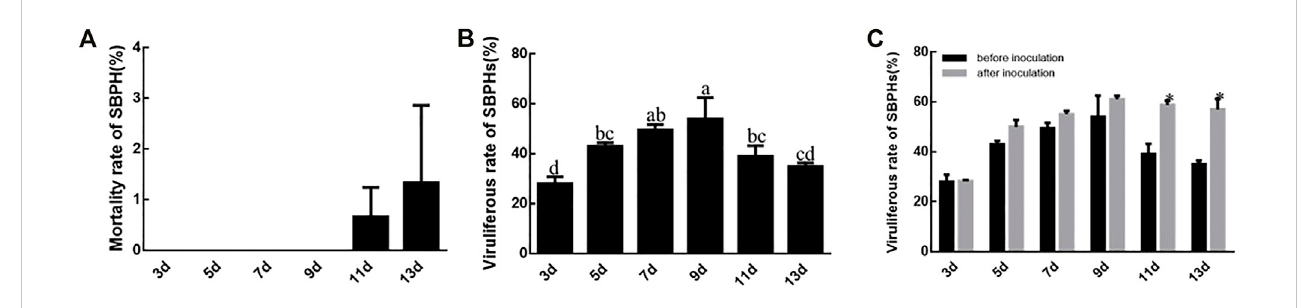
FIGURE 3 SBPH mortality and RBSDV viruliferous rates of SBPHs. (A) , SBPH mortality with different virus feeding times. (B) , RBSDV viruliferous rates of SBPHs with different virus feeding times. (C) , Comparison of RBSDV viruliferous rates with different virus feeding times before and after inoculation. The different letters above the columns represent statistical signi fi cance between treatments according to Duncan ’ s multiple tests; p < 0.05.